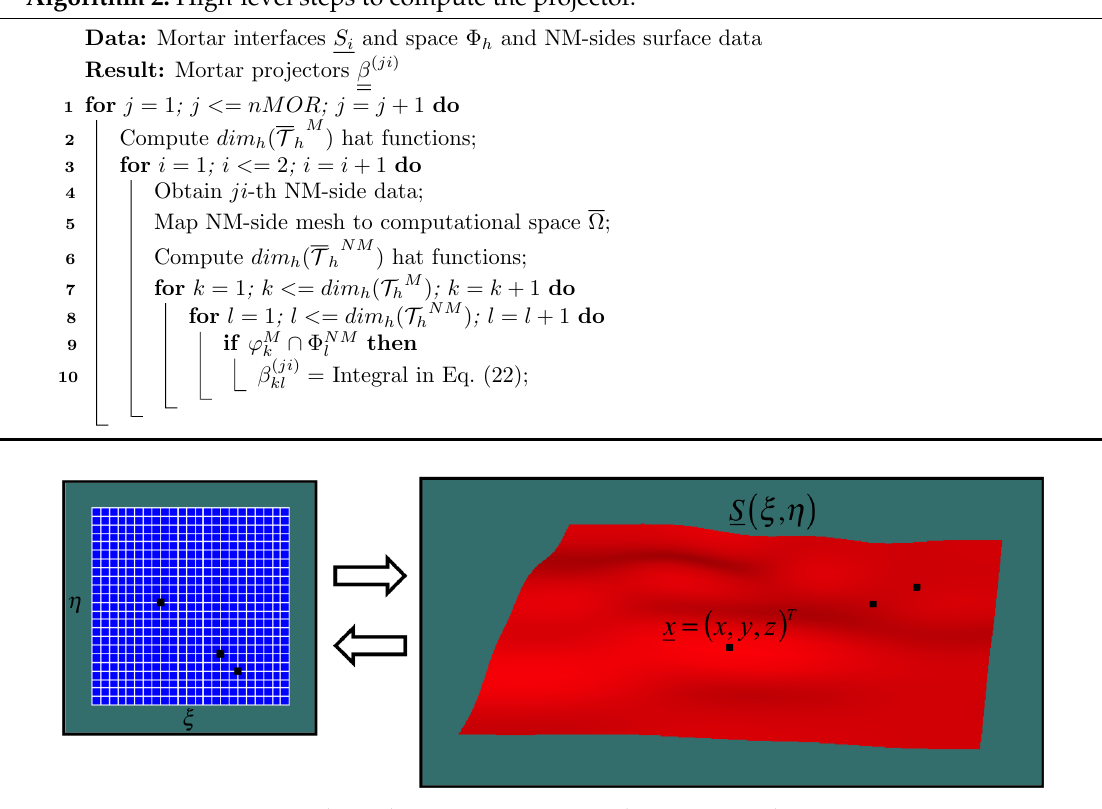
Figure 3: Physical space to computational mappings and vice-versa Algorithm 2: High-level steps to compute the projector.